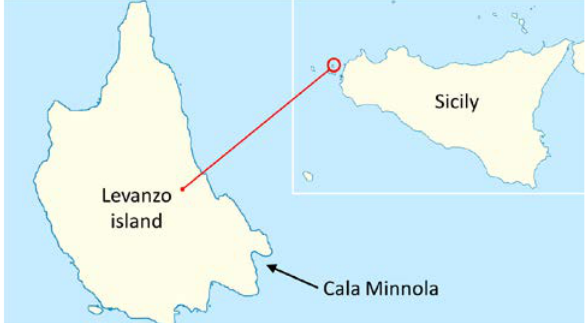
Figure 1. Geographical localization of the underwater archaeological site of Cala Minnola